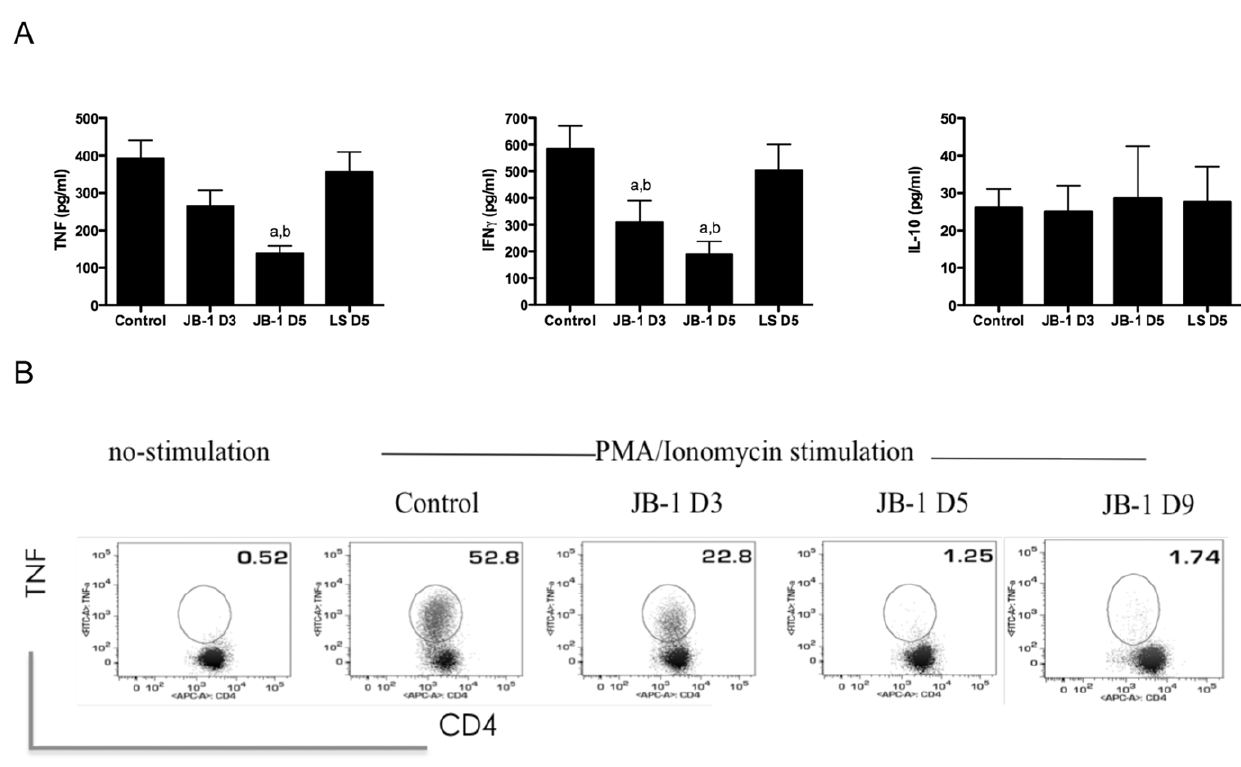
Figure 3. Feeding of JB-1 reduces secretion of inflammatory cytokines by T cells. Balb/c mice were given L. rhamnosus (JB-1), L.salivarius (LS) or vehicle by gavage for 3 or 5 days. (A) Single cell suspensions of mesenteric lymph nodes were stimulated by antibodies against CD3/CD28 for 48 hr and the supernatants were analyzed for cytokine productions using Cytometric Bead Array Assay. Mean 6 SEM values for TNF, IFN- c and IL-10 release are depicted (n=6 a, b=P , 0.05 compared to vehicle and LS respectively). (B) Single cell suspensions of mesenteric lymph nodes were stimulated by PMA and ionomycin for 4 hr and intracellular TNF by CD4 + CD3 + T cells were depicted data are representative of three similar independent